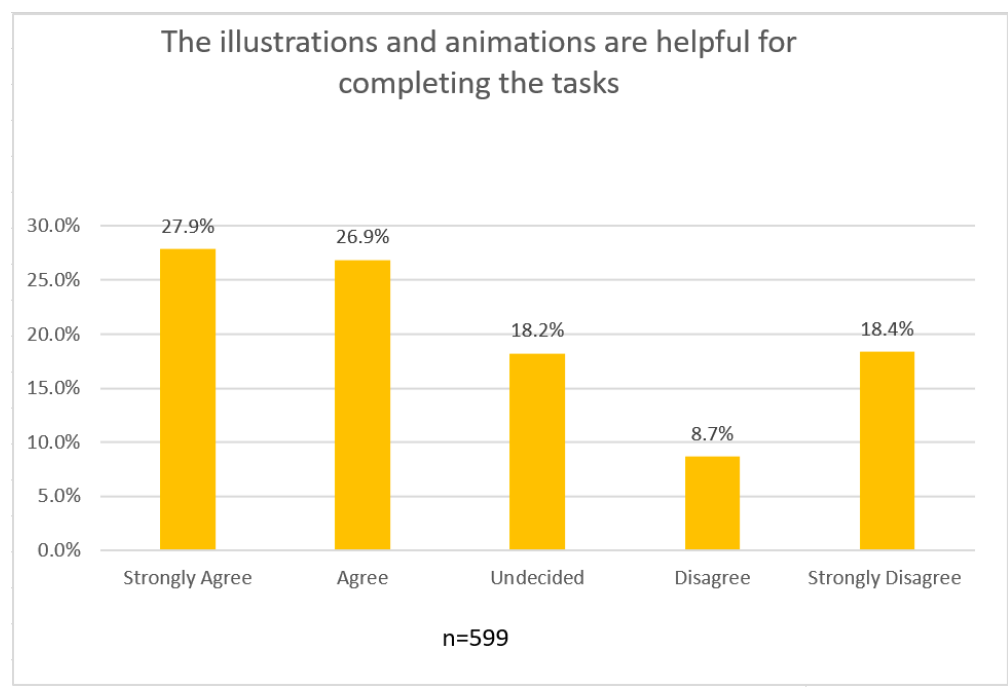
Figure 7. Pupils agreement with the statement: “The illustrations and animations are helpful for completing the tasks”.